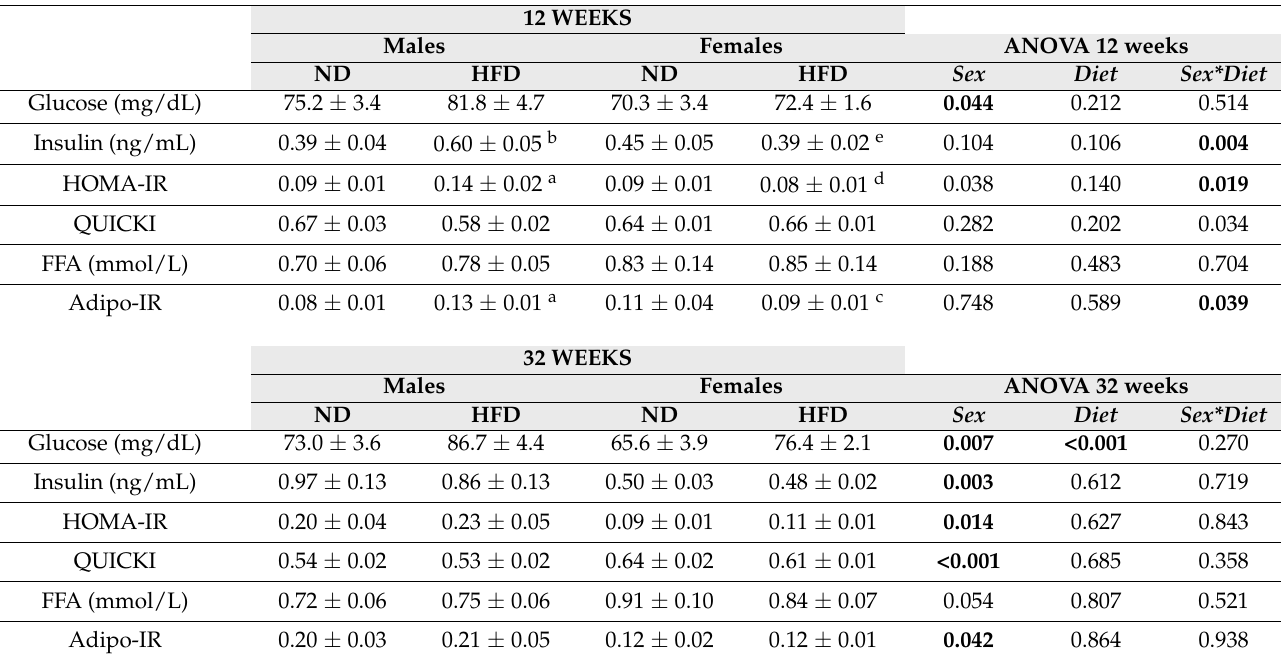
Table 2. Effect of sex and diet on glucose metabolism in 12-and 32-week-old mice. 12 WEEKS Males